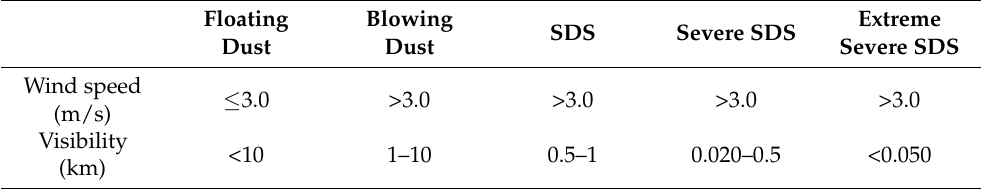
Figure 1. Locations of the 673 standard ground weather stations in China. Table 1. Wind speed and visibility in sand and dust